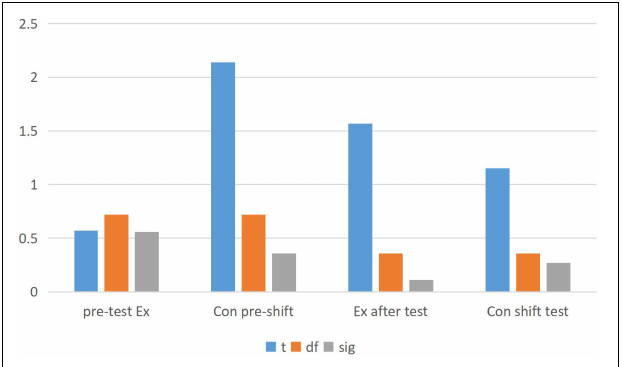
FIGURE 5 | Comparison of the sample test values between the experimental classes and the control